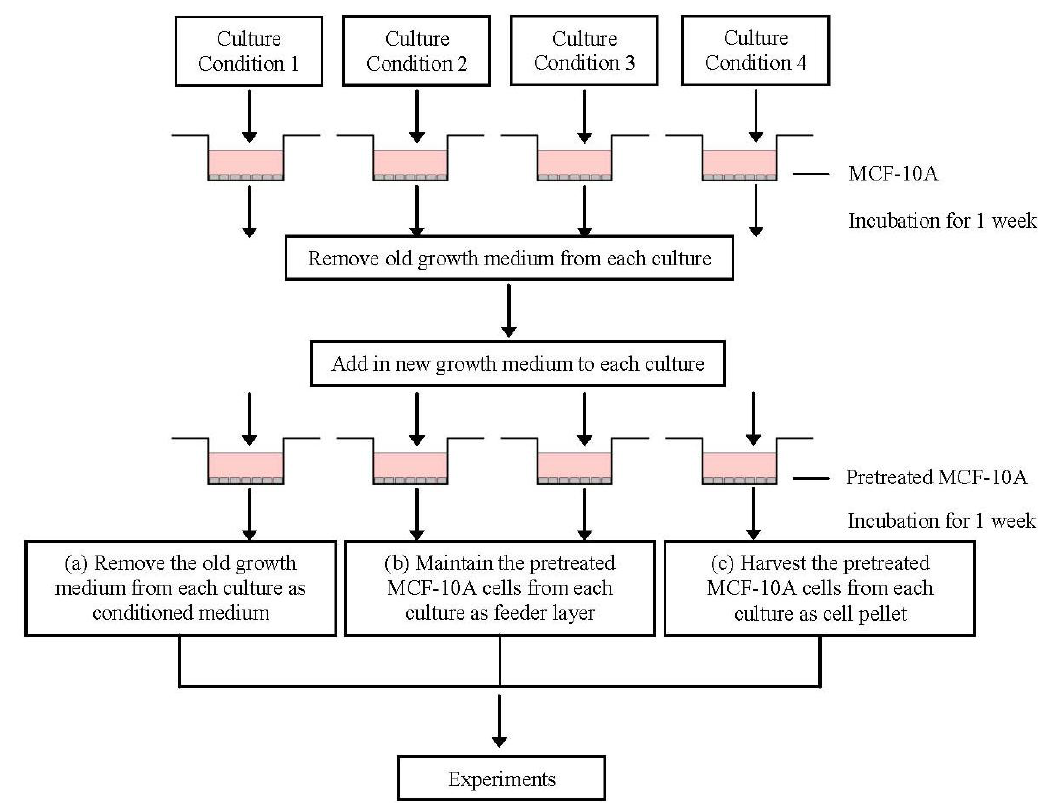
Figure 10. Schematic of the conditioned media and MCF-10A cells preincubated with pioglitazone and/or serum-rich growth media